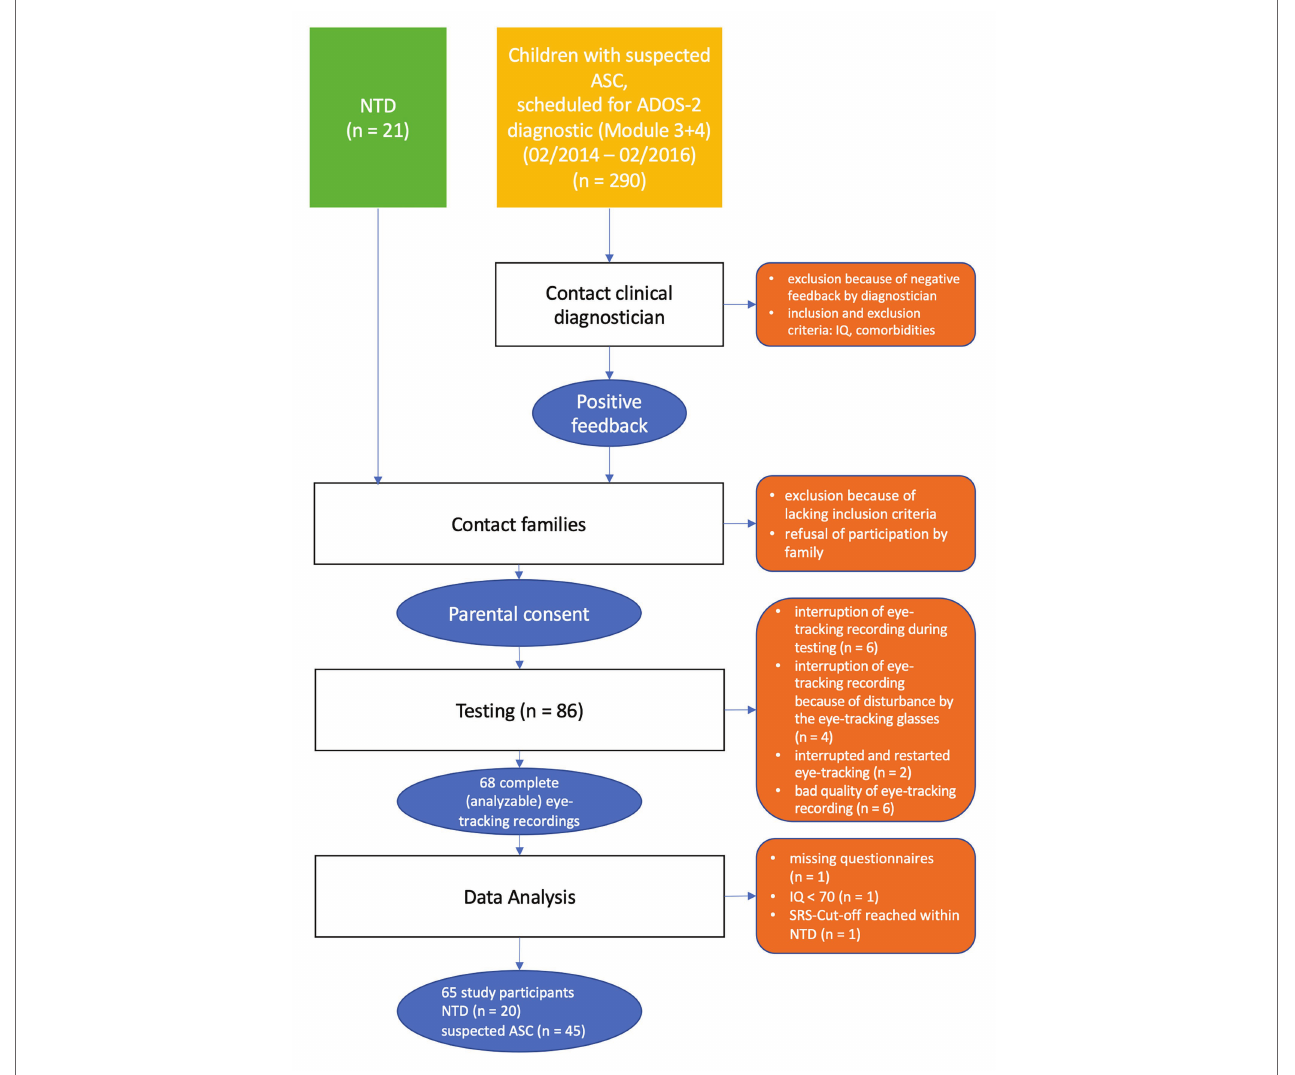
FIGURE 1 | Flow of